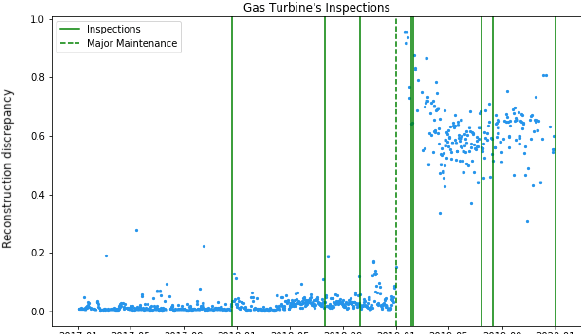
Figure 4. Maintenance dataset together with Fresh Reconstruction Discrepancy of FC3D model.